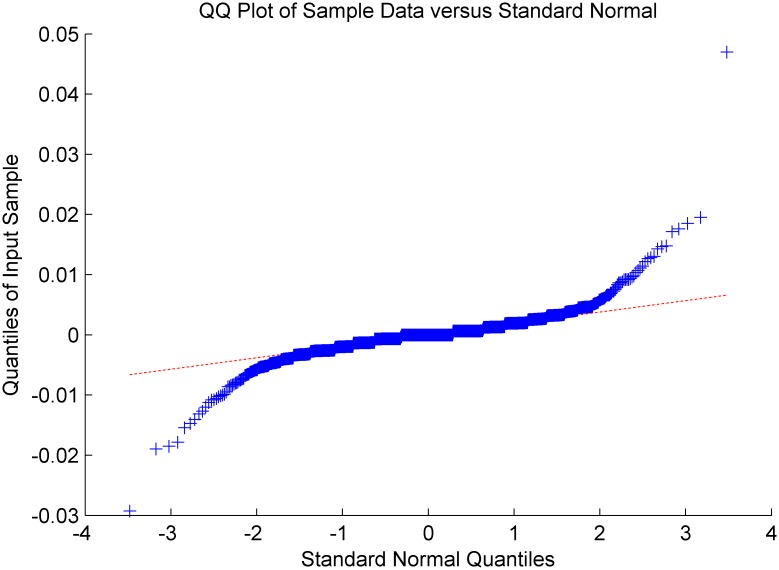
The return series QQ graph of CDA.